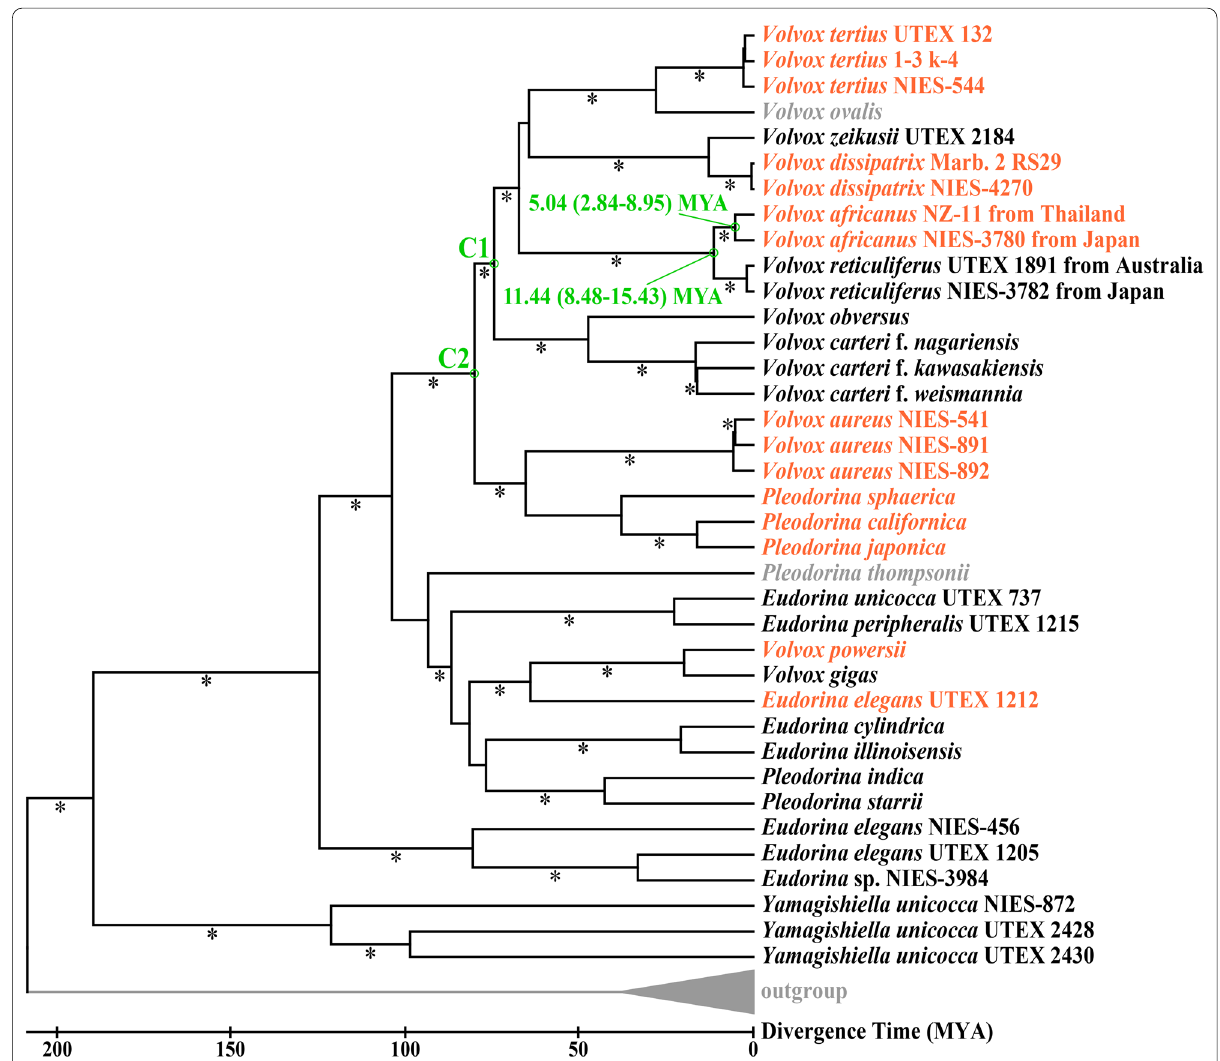
Fig. 4 Timetree analysis of advanced members of the colonial volvocine algae including the Thai strains of Volvox africanus . Note that the divergence time between heterothallic Volvox reticuliferu s and homothallic V. africanus and the divergence between Thai and Japanese strains of V. africanus are “11.44 (8.48–15.43) MYA” and “5.04 (2.84–8.95) MYA”, respectively. Species names in orange or black indicate homothallic or heterothallic sexuality, respectively. Tree topology was inferred by maximum likelihood (ML) analyses of 6021 base pairs of five chloroplast genes from 47 operational taxonomic units [TreeBASE (Vos et al. 2010, 2012) ID 28191] with a model selected by MEGA X (Kumar et al. 2018). Asterisks on branches indicate 80% or more bootstrap values (based on 1000 replicates) by the ML analyses. A timetree was inferred by applying the RelTime method (Tamura et al. 2012, 2018) to the ML phylogenetic tree whose branch lengths were calculated using the ML method and the General Time Reversible substitution model (Nei and Kumar 2000). The timetree was computed using two calibration constraints [C1 (65–90 MYA) and C2 (50–90 MYA)] based on TimeTree: the Time Scale of Life <http:// www. timet ree. org/> (Liss et al. 1997; Herron et al. 2009). Outgroup was designated as in the previous study (Yamamoto et al. 2021). Evolutionary analyses were conducted in MEGA X (Kumar et al.